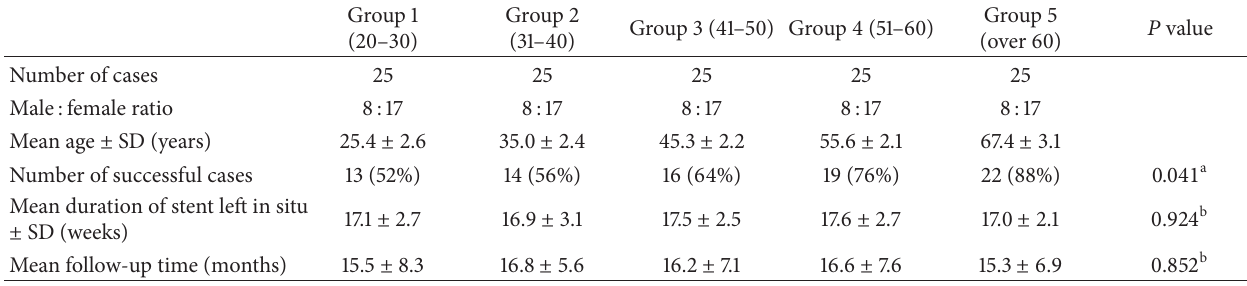
Table 1: Comparison of the characteristics and the success rate of the TCL-DCR in different age groups.